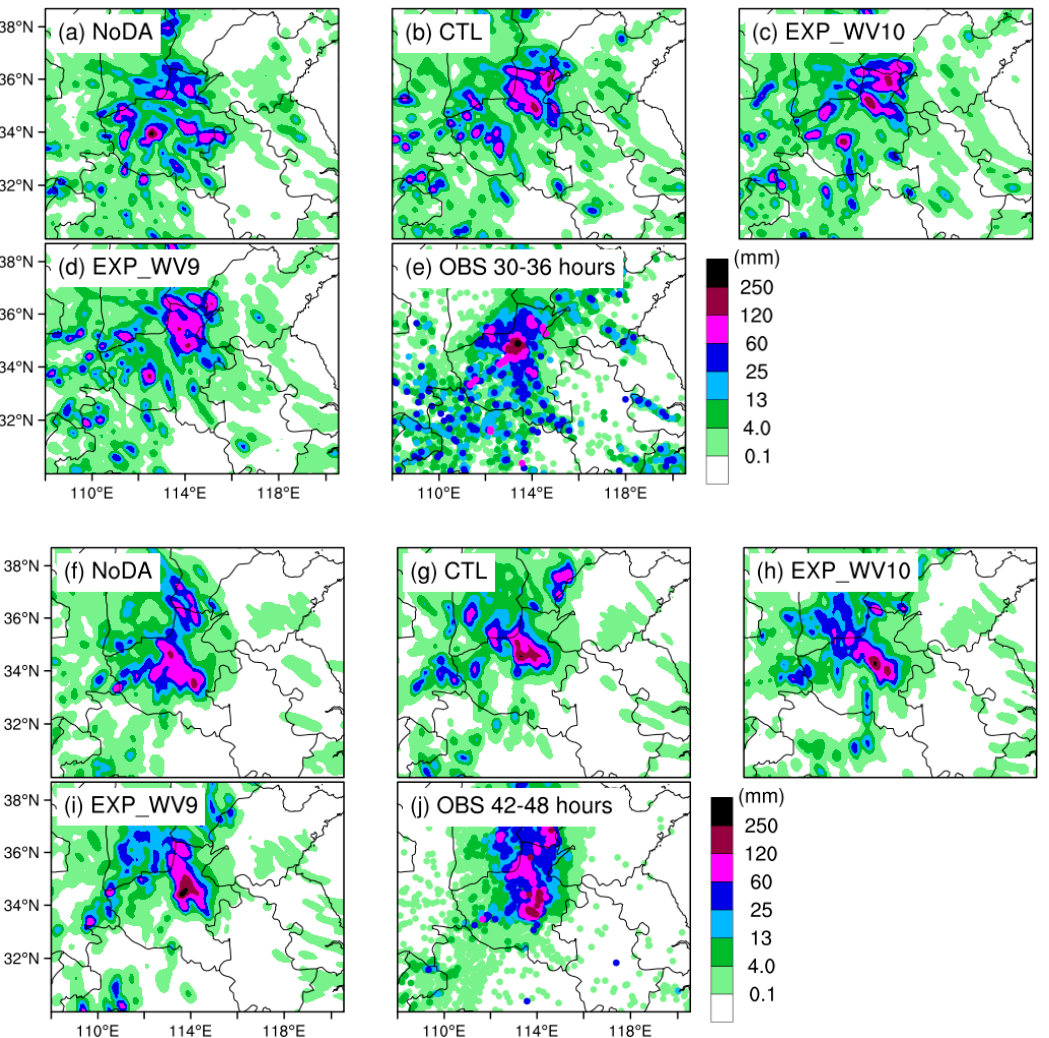
Figure 16. Comparison of the 6 h accumulated precipitation from different experiments and ob- servations from ( a – e ) 0600 UTC 20 July to 1200 UTC 20 July 2021, and ( f – j ) 1800 UTC 20 July to 0000